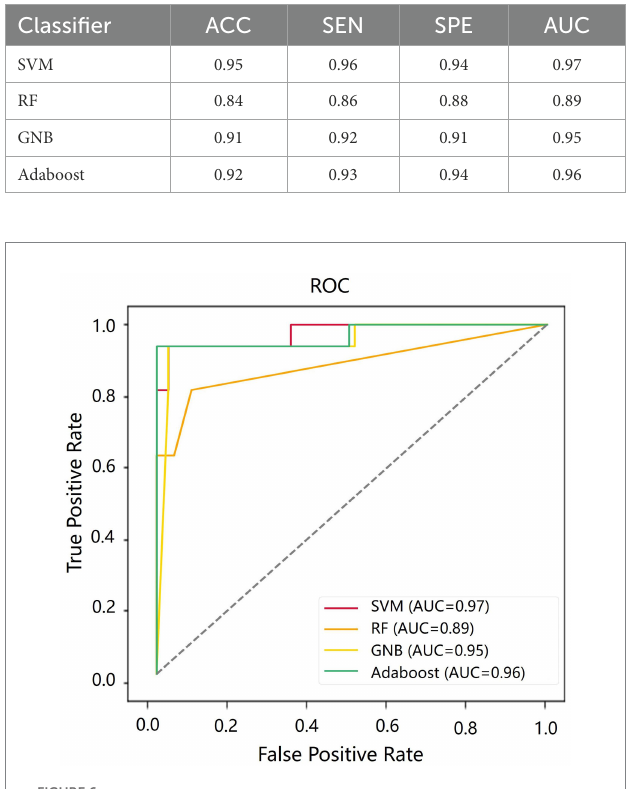
FIGURE 6 The receiver operation characteristics (ROC) curve of SVM in the test